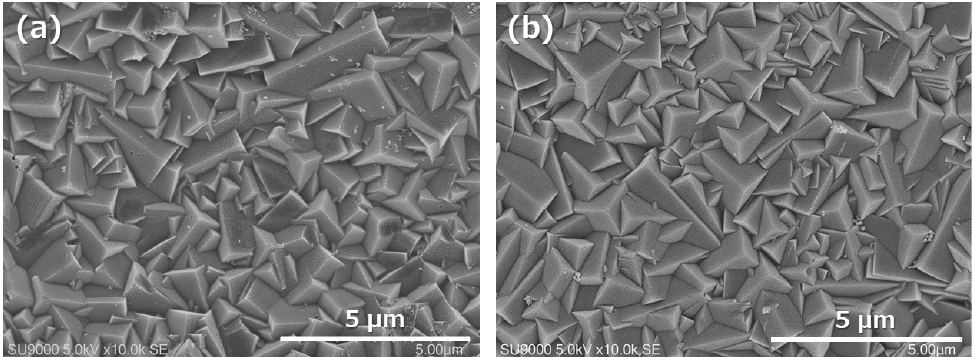
Figure 2. Surface SEM images of ( a ) the Si-rich LTA membrane and ( b ) conventional LTA membrane.